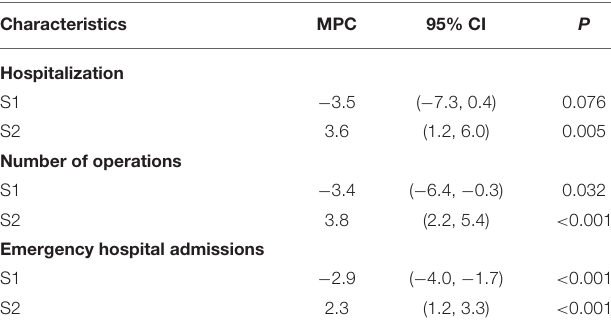
TABLE 1 | Trend analysis of medical service capability.